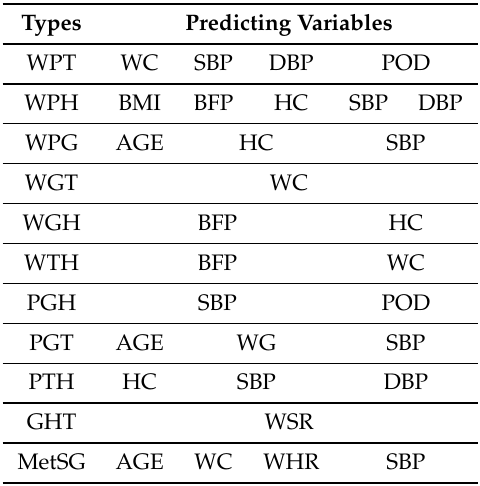
Table 10. Selection of predicting variables for each MetS type from original dataset.